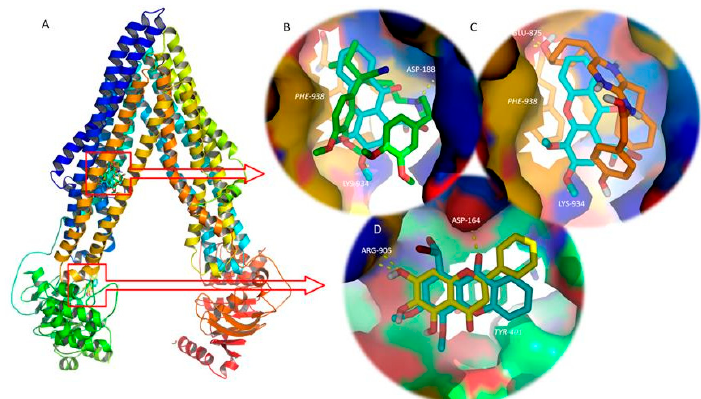
Figure 9. ( A ) Ribbon representation for the P-glycoprotein (P-gp) model and control/test molecules docked to the transmembrane domains (TMD, top) and nucleotide binding domain (NBD, bottom). ( B ) Detailed view of the P-gp inhibitor, verapamil (green sticks), and test xanthone OX2 (blue sticks) on the drug binding site on the interface of the TMDs. ( C ) Detailed view of the P-gp activator, coelenteramide (orange sticks), and test xanthone OX2 (blue sticks) on the drug binding site on the interface of the TMDs. ( D ) Detailed view of the P-gp inhibitor, baicalein (yellow sticks), and test xanthone OX2 (blue sticks) on the NBD. Polar interactions are represented as yellow broken lines and evolved residues are labelled. Residues involved in stacking interactions are represented in sticks and labelled in